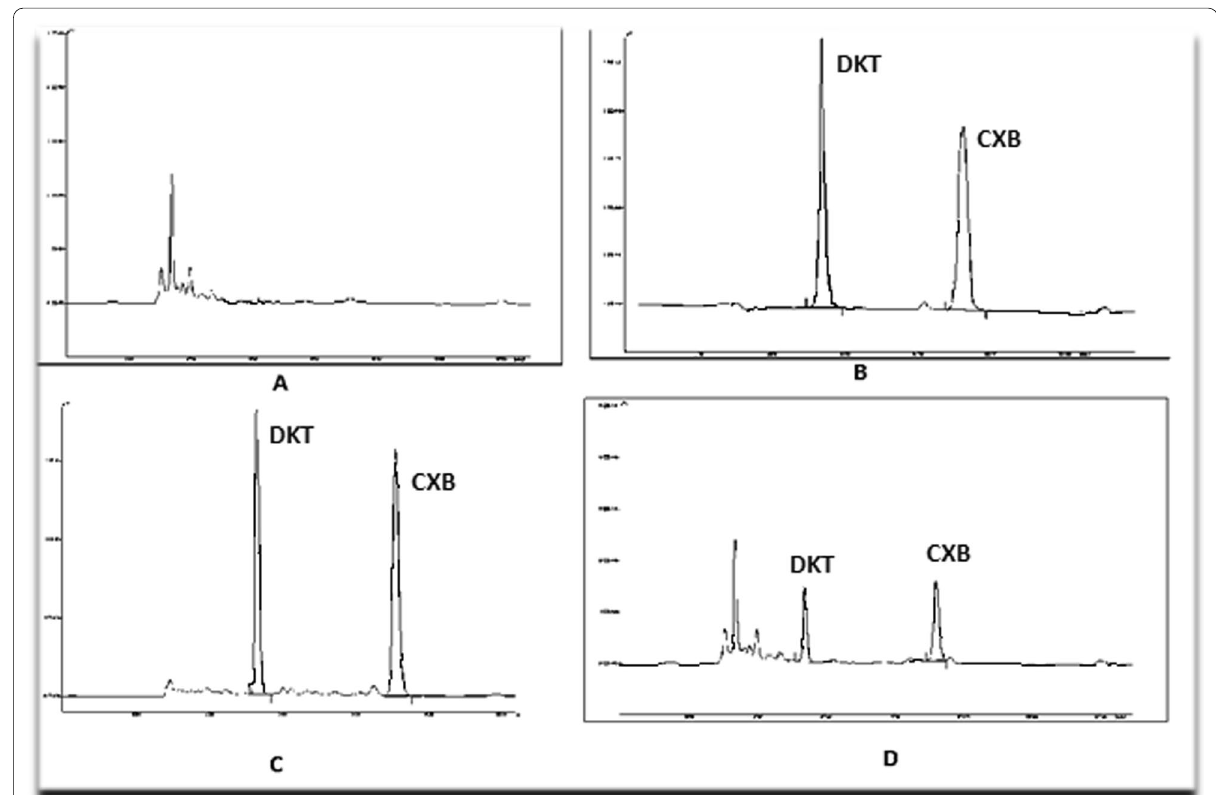
Fig. 1 Chromatogram of A blank plasma sample B blank plasma sample with DKT (IS) C plasma sample spiked with I. S. DKT (10 µg/ml) and CXB (10 µg/ml) D a plasma sample obtained from rat at 1.5 h after oral administration of